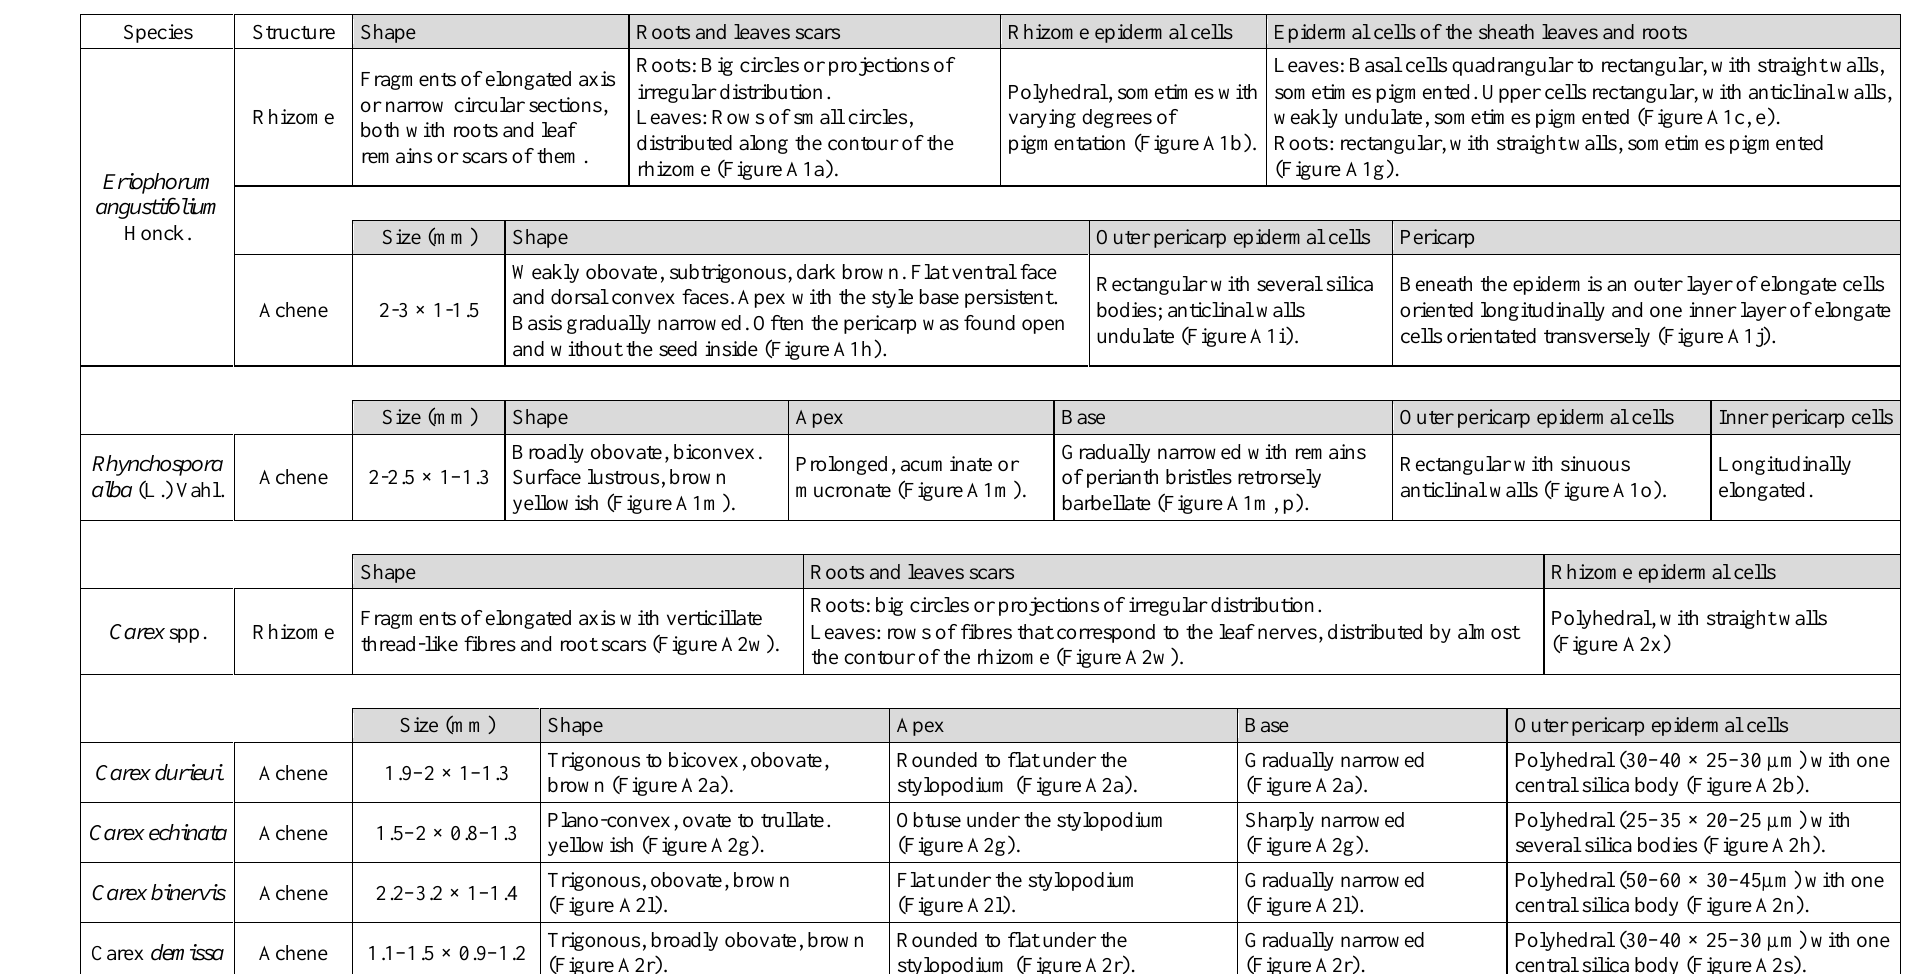
Table A1. Monocotyledons: Cyperaceae. Nomenclature of achene morphology follows Berggren